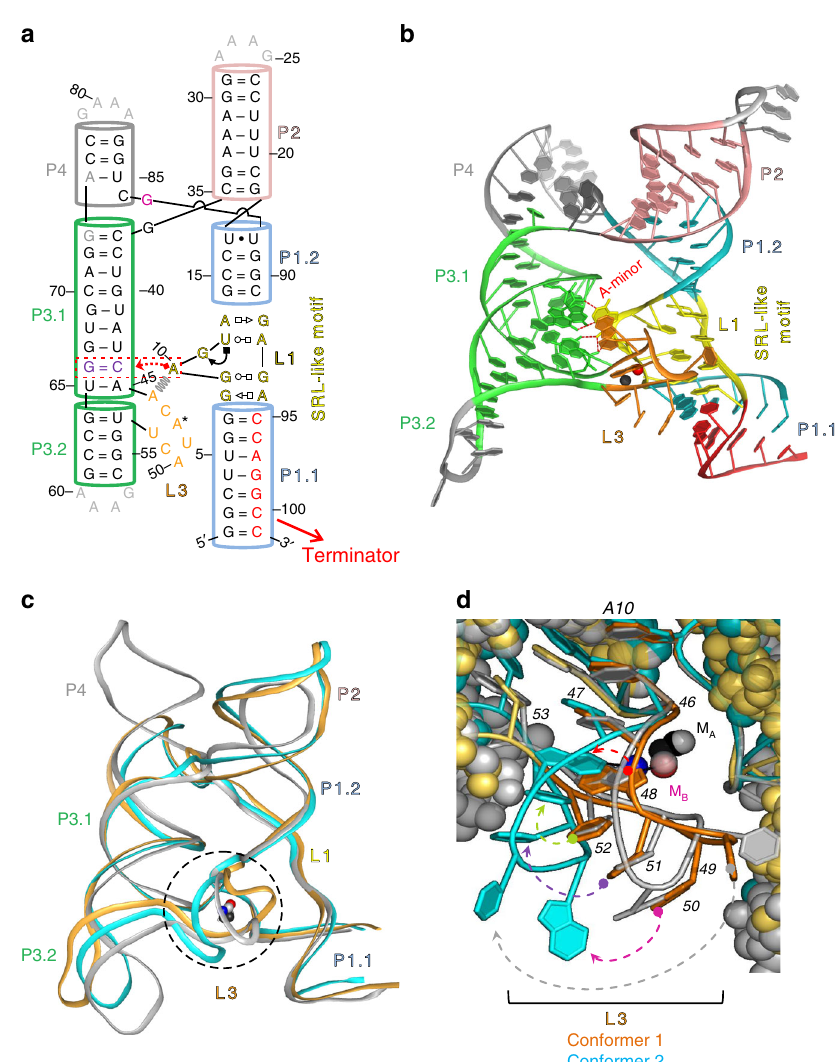
Fig. 1 Sequence and structure of the X. oryzae ( Xory ) crystal structure. a Secondary structure of the X. oryzae crystal construct. A native CA dinucleotide was omitted between G73 – A74 for crystallization purposes only. The A-minor interaction between L1 and L3 and the SRL-like conformation of L1 is shown. b Crystal structure of Conformer 1 (PDB ID: 6N2V) with different secondary structures labeled. c Comparison of overall structures of Conformers 1 (orange) and 2 (cyan) and the previous Mn 2 + -bound L. lactis structure (gray). The two molecules in the asymmetric unit are overall fairly similar. However, they differ dramatically at the metal ion binding sites (dotted circle). d Conformer 1 (orange) is relatively similar to the L. lactis structure at the M B,Mn binding site. All the same metal ion contacts are made, although U49, away from the Mn 2 + site, is shifted (gray dotted arrow). Conformer 2 (cyan) differs in that a metal ion is still bound at the M B,Mn site, but only half of the metal ion contacts are made, and the binding site A48 is fl ipped (red dotted arrow) to expose N1 rather than N7. U49 (gray arrow), A50 (magenta arrow), C51 (purple arrow), and U52 (green arrow) are all signi fi cantly shifted from the previously reported Mn-bound